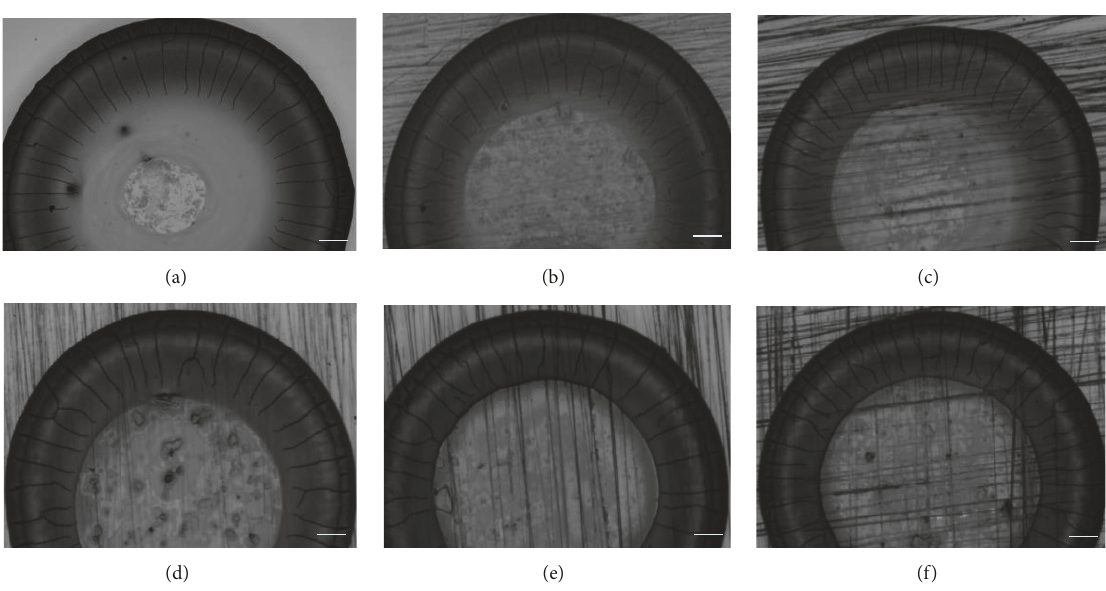
Figure 3: Evaporation patterns of PTFE colloidal droplets on glass slides with different roughness: (a) smooth glass; (b)–(f) increasing surface roughness, achieved using sandpaper with mesh sizes of 1500, 1000, 800, 400, and 200, respectively (scale bars represent 100 𝜇